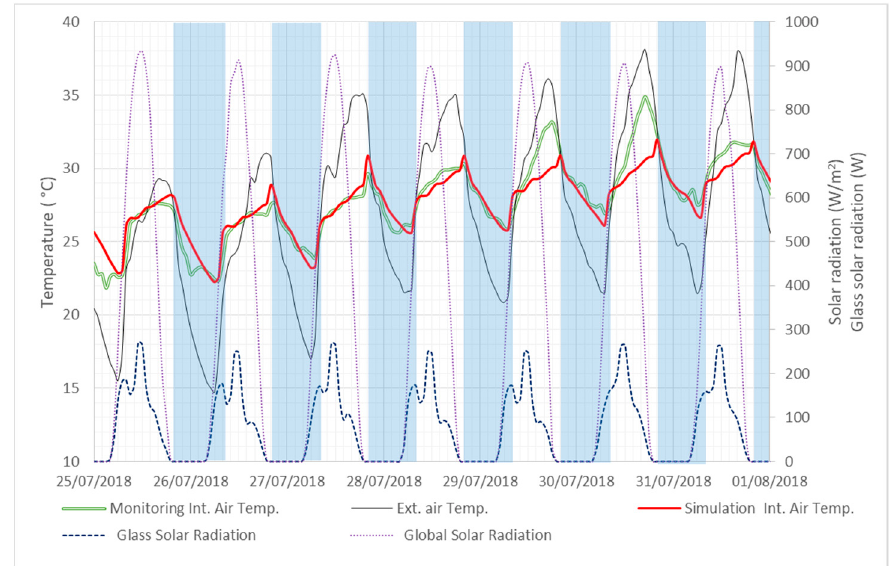
Figure 10. Interior monitored and simulated air temperature, solar radiation and exterior temperature during night cross ventilation (ventilation time represented in blue area).